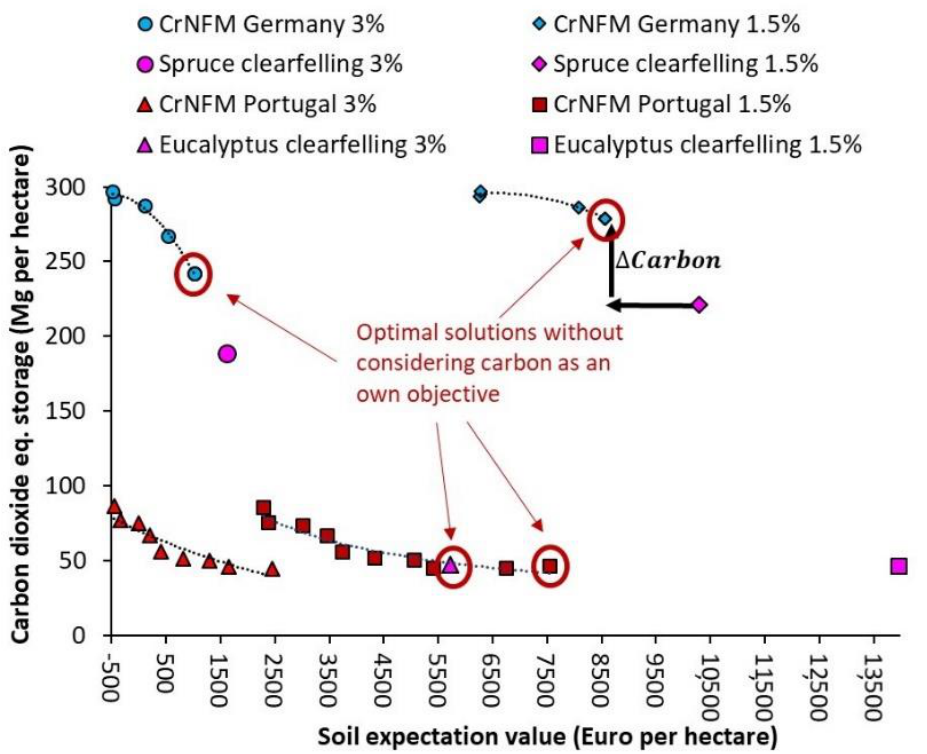
Figure 1. Trade-offs between the storage of carbon dioxide and the soil expectation value. The different carbon–SEV pairs were obtained using different weightings of the carbon and economic return objectives.